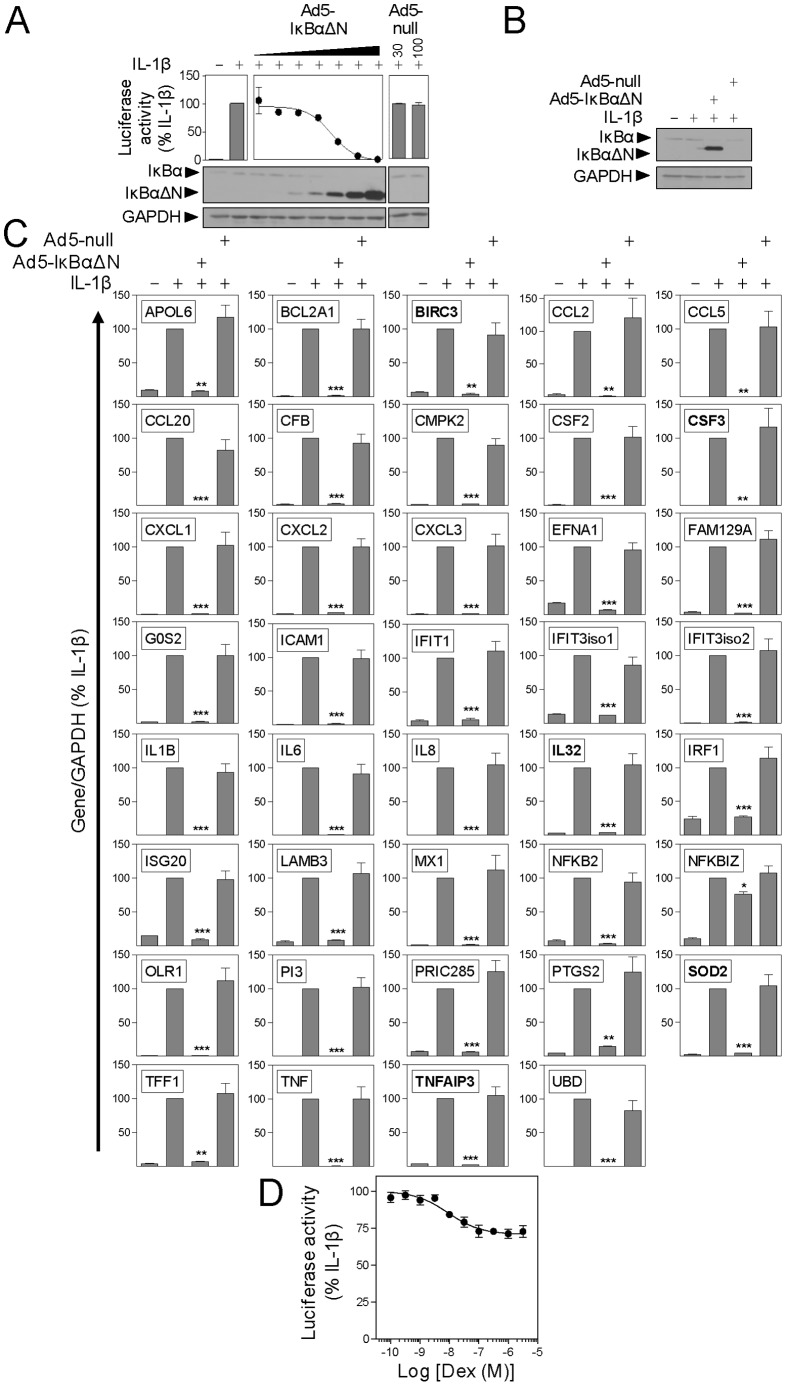
Effect of IκBαΔN on inflammatory gene expression.
A. A549 cells were infected with the NF-κB-dependent reporter, Ad5-NF-κB-luc, in the presence of Ad5-IκBαΔN (0.1–100 MOI) or Ad5-null. After 36 h, cells were stimulated with IL-1β (1 ng/ml) for 6 h before harvesting for luciferase assay and western blot analysis of IκBα and GAPDH. Data (n = 2) expressed as percentage of IL-1β are plotted as mean ± SE. Representative blots are shown. B. A549 cells were infected with 100 MOI of Ad5-IκBαΔN or Ad5-null for 24 h prior to stimulation with IL-1β for 6 h. Cells were harvested for western blot analysis of IκBα and GAPDH. Blots representative of 4 experiments are shown. C. Cells from B were harvested for RNA and SYBR green real-time PCR carried out for GAPDH and the indicated genes. Data (n = 4) normalised to GAPDH and expressed as percentage of IL-1β are plotted as mean ± S.E. Significance relative to IL-1β was tested using AVOVA with a Dunnett’s post-test. * P<0.05; ** P<0.01; *** P<0.001. Genes not significantly repressed by dexamethasone (from Figure 2A) are highlighted in bold font. D. A549 cells infected with the NF-κB-dependent reporter, Ad5-NF-κB-luc, for 36 h were incubated with various concentrations of dexamethasone, as indicated, for 1 h prior to stimulation with IL-1β. After 6 h cells were harvested for luciferase assay. Data (n = 5) expressed as percentage of IL-1β are plotted as mean ± SE.